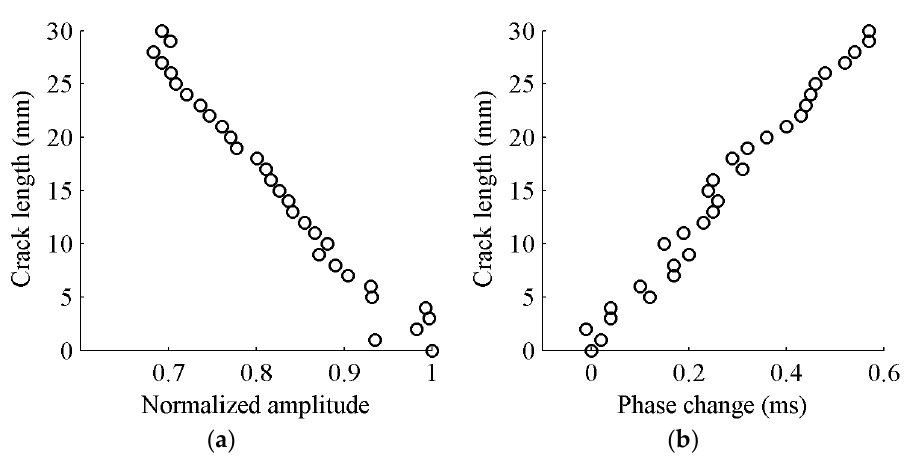
Figure 6. Crack length versus damage sensitive features: ( a ) normalized amplitude; and ( b ) phase change.